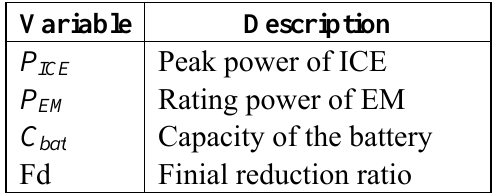
Table 1. Key parameters of the powertrain